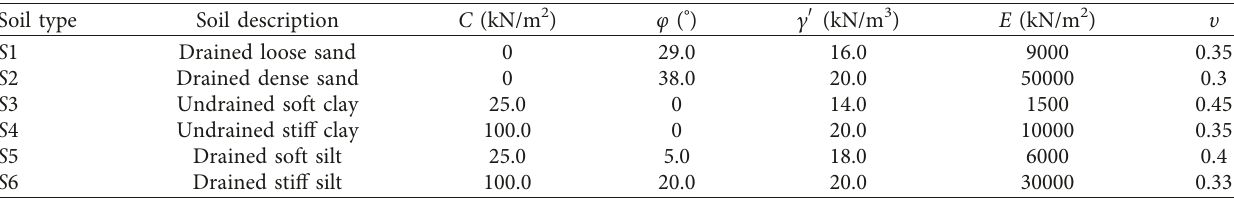
Figure 1: 2-dimensional plane strain model underlain with bilayered soils. Table 1: Six (6) soil types and their profile